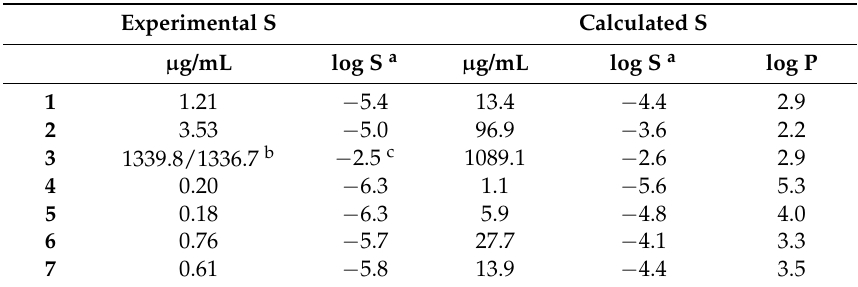
Table 1. The experimental and calculated aqueous solubility(S) of derivatives 1 – 7 , as well as their predicted log P. Experimental S Calculated